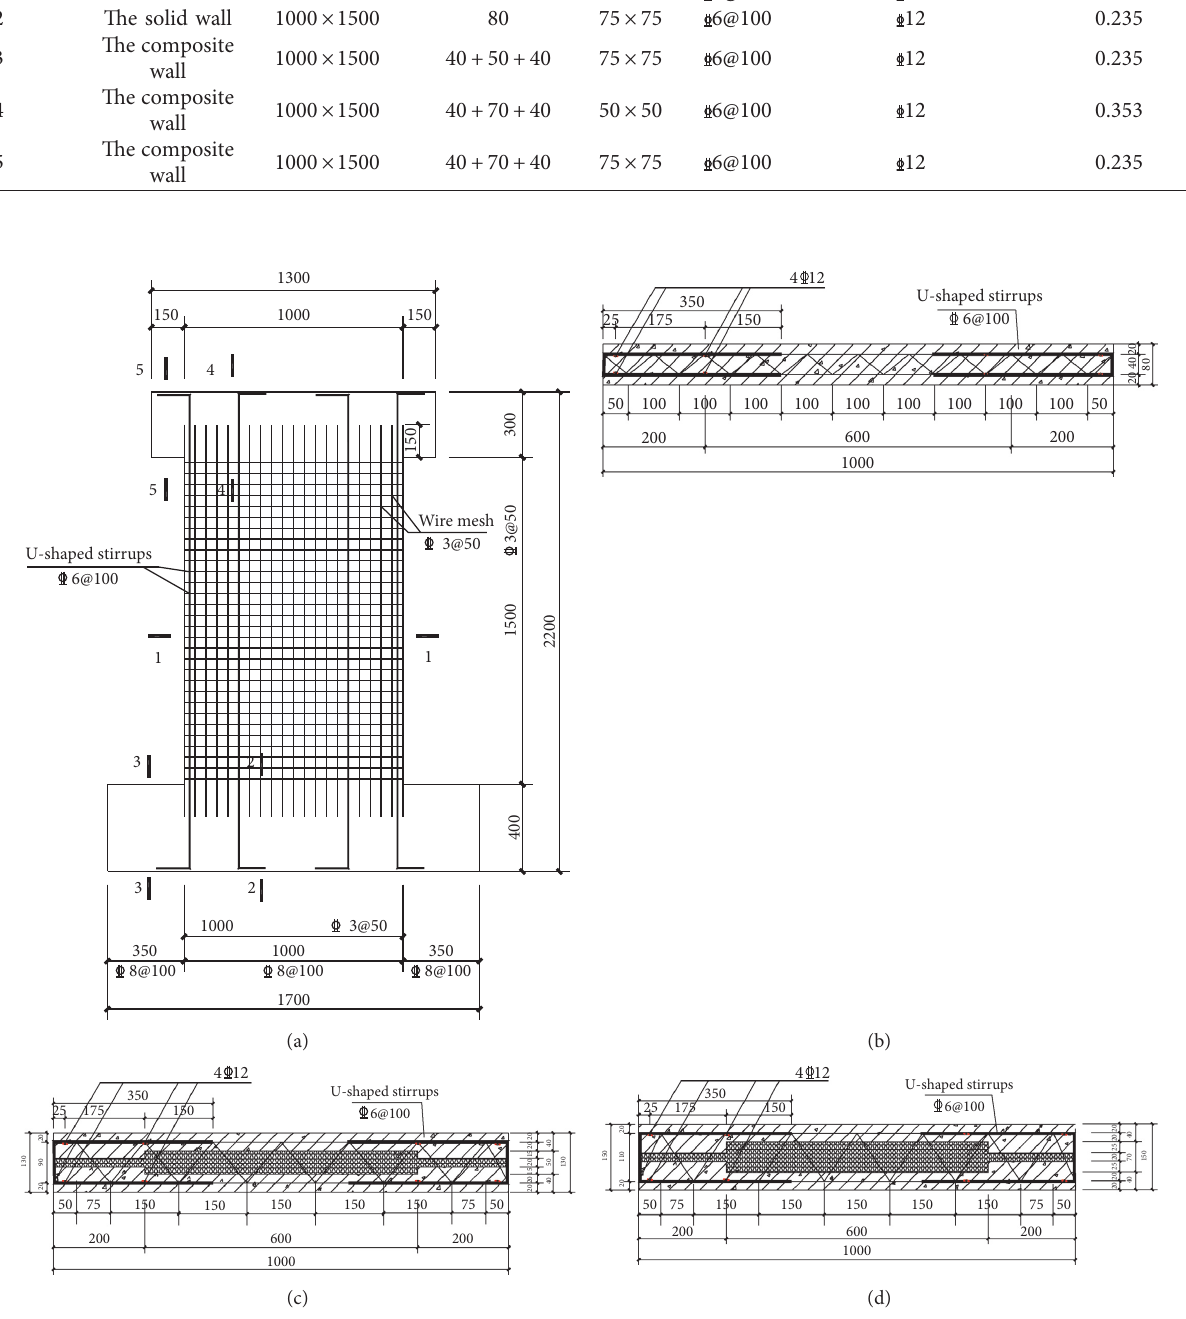
Figure 1: Dimensions and reinforcement details. (a) Elevation. (b) Section 1-1 of W1 and W2.(c) Section 1-1 of W3. (d) Section 1-1 of W4 and W5. Table 2: Mechanical properties of